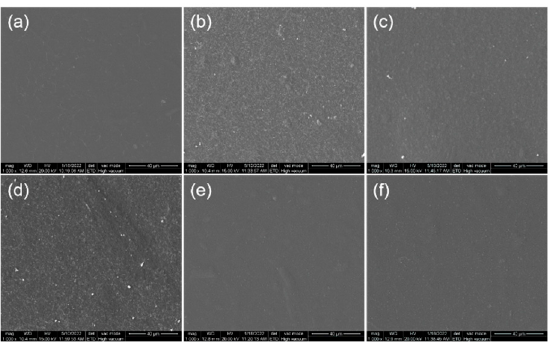
Figure 2. SEM images of pure CNFs and different composite films. ( a ) CNF; ( b ) CNF/P1; ( c ) CNF/P2; ( d ) CNF/P3; ( e ) CNF/M1; ( f ) CNF/M2. Magnification: 1000×.